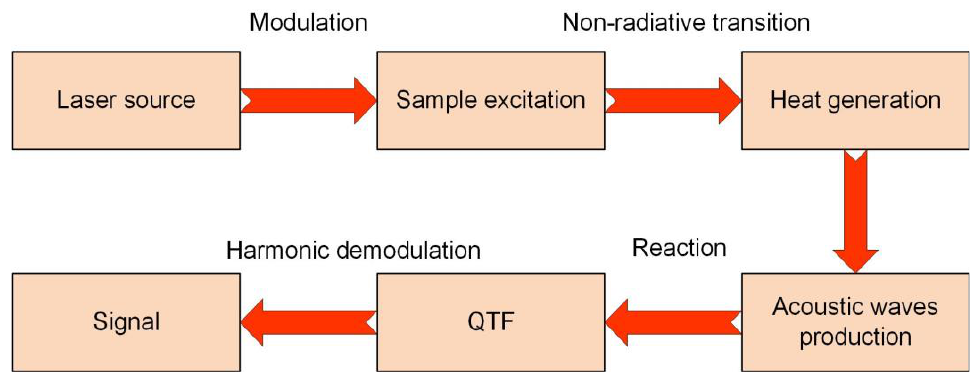
Figure 1. The schematic diagram of